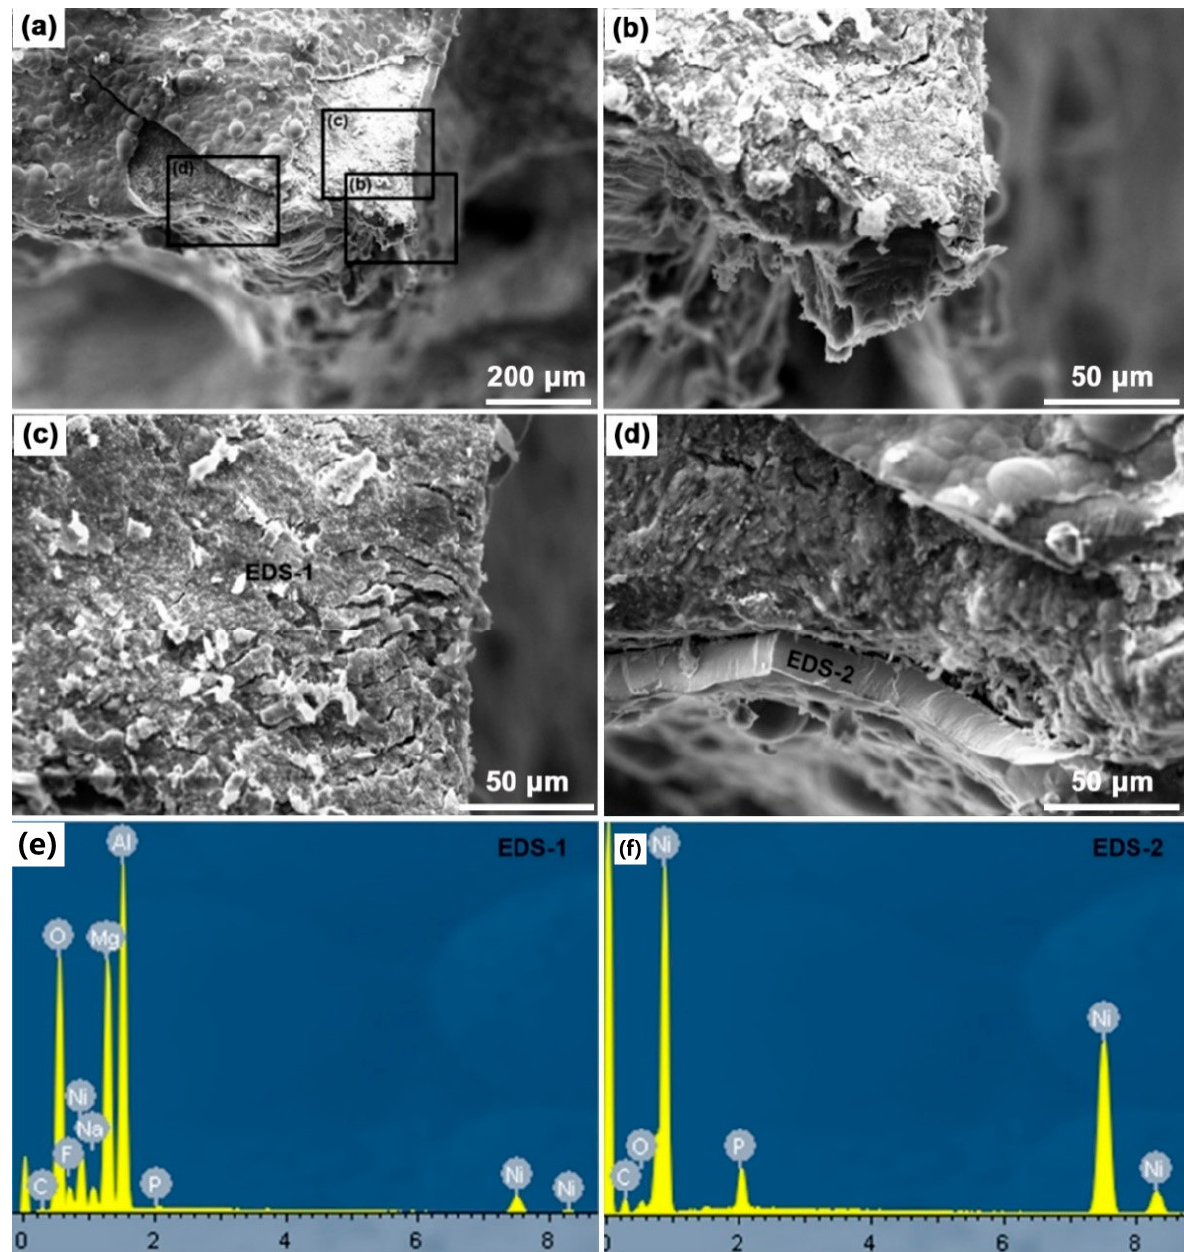
Figure 10. The fracture morphologies and EDS analysis of hybrid foams at RT: ( a ) fracture of the foam struts; ( b – d ) enlarged picture in the box marked in ( a ) that showing parts of the foam struts; ( e , f ) are energy spectra of EDS-1 and EDS-2, respectively.